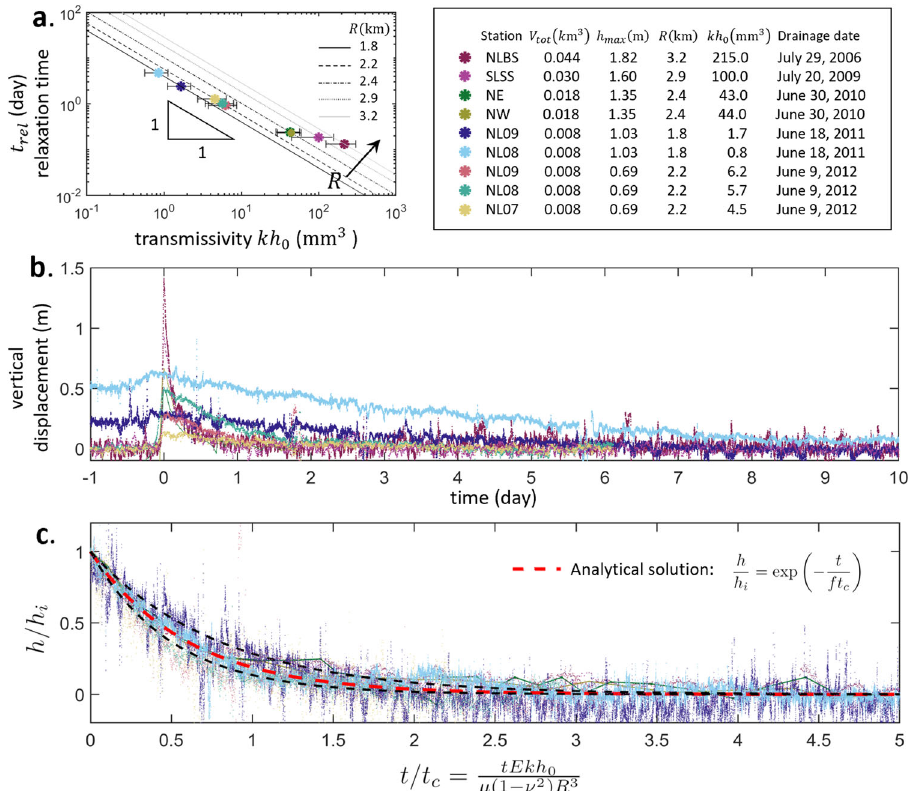
Fig. 3 Hydraulic transmissivity and the universal dynamics of uplift relaxation. a The relaxation time t rel obtained from surface uplift data from different stations and the predicted hydraulic transmissivity kh 0 . Detailed information for each data set is shown in the table. Here the supraglacial lake volume is assumed to be the total volume V tot injected into the blister and the water sheet. The black lines ( t rel ¼ f μ R 3 ð 1 (cid:3) ν 2 Þ E ð kh 0 Þ (cid:3) 1 ) are the model predictions for different blister radii R . The lake volume V tot of Lake F and North Lake listed in the table are taken from references 1,2,6 and the lake volume of South Lake is estimated in the Methods. Surface uplift data from fi ve drainages of three different lakes as recorded by seven different GPS stations are plotted in ( b ) dimensional and ( c ) dimensionless forms. Despite a wide range of relaxation times, when rescaled by the characteristic relaxation time t c (Eq. (4)) and initial vertical displacement h i , all fi eld uplift data collapse onto the exponential analytical solution (Eq. (7), red dashed line ( c ) with f ¼ 0 : 6 averaged over all datasets (Methods)). Upper and lower dashed lines represent the solutions with the highest and lowest f (Table 1), respectively, among all the data